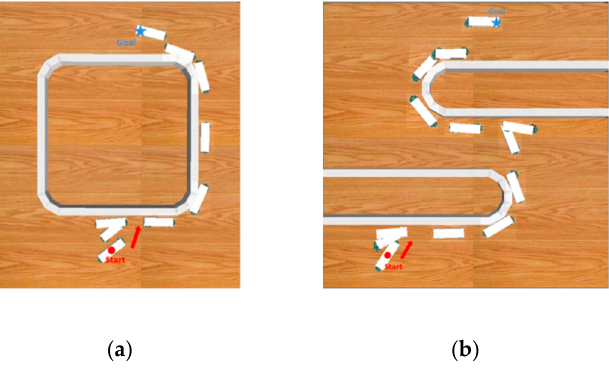
Figure 30. Navigation control of cooperative carrying in ( a ) test environment 1 and ( b ) test environment 2.